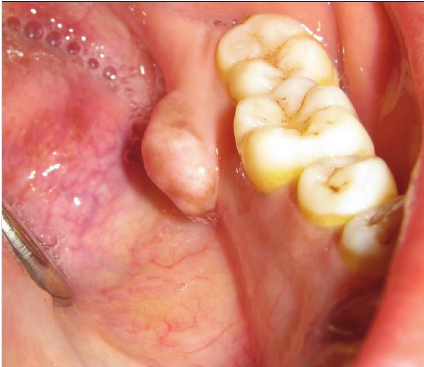
Figure 1: Intraoral picture of the lesion.